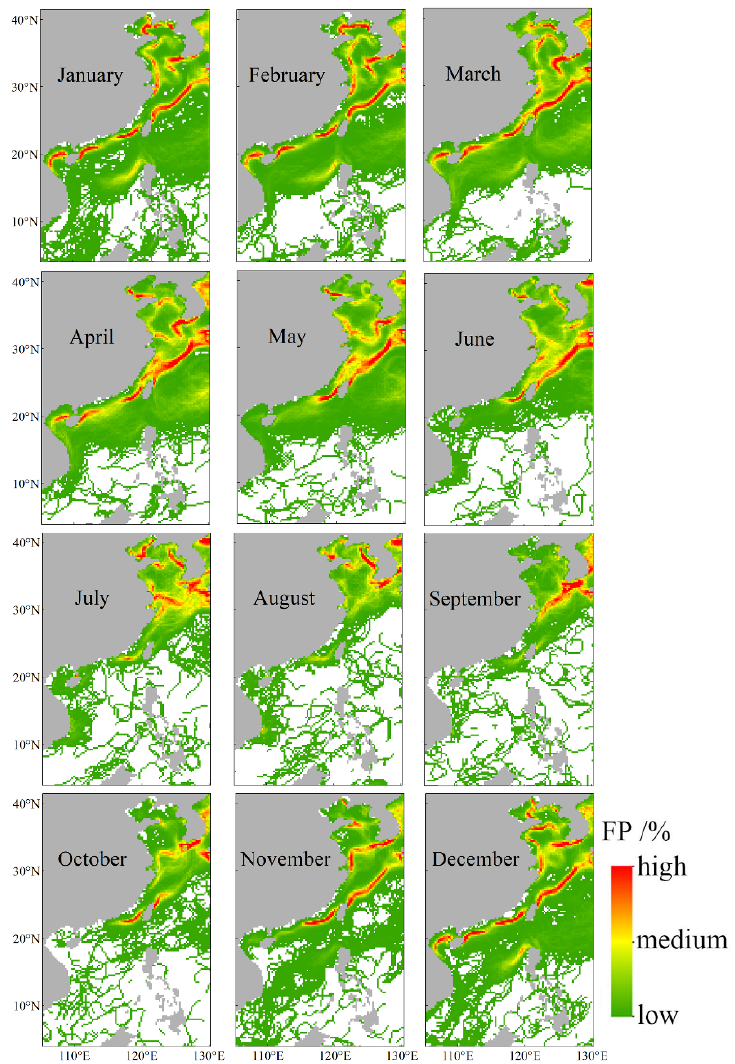
Figure 2. Monthly frontal probability maps for 1982–2021. Table 1. Monthly high-, medium-, and low-frequency fronts.